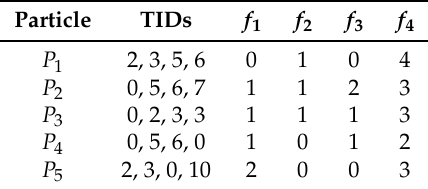
Table 4. The initial